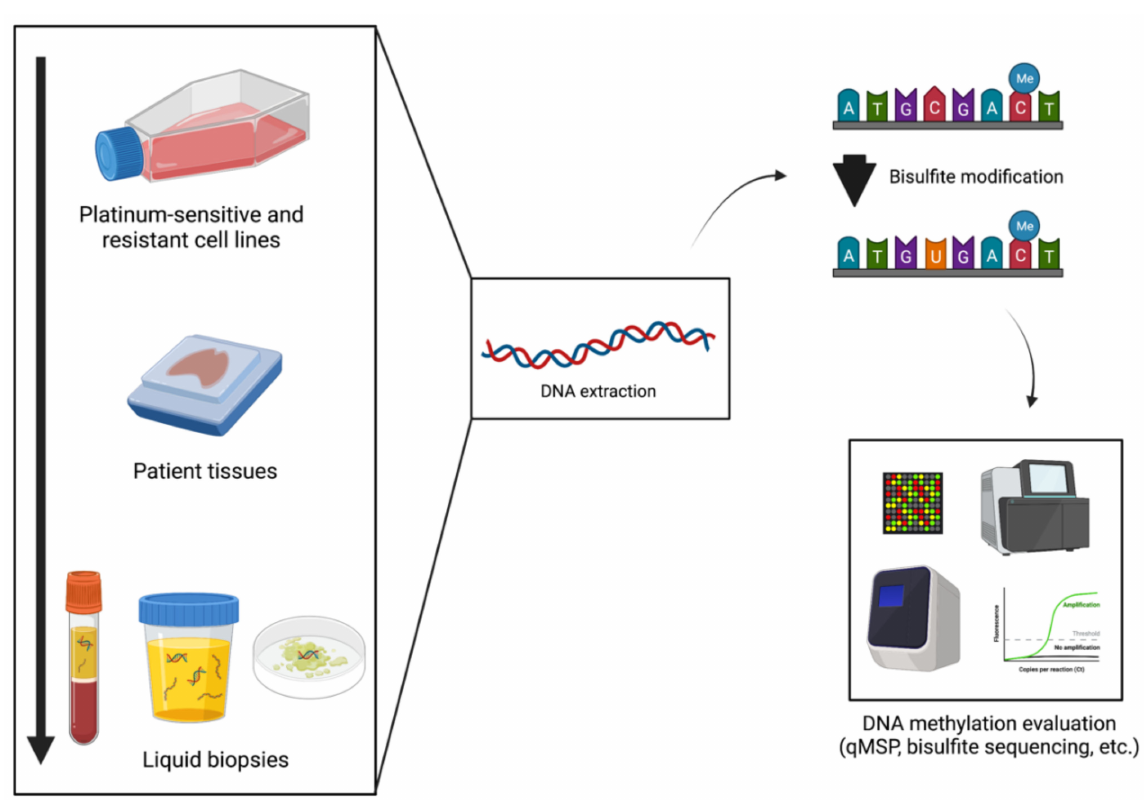
Figure 1. Platinum- resistance DNA methylation biomarkers’ examination process. Created with BioRender.com (accessed on 1 February